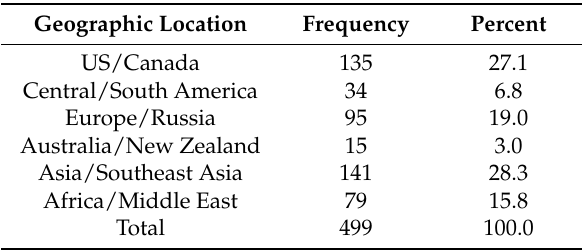
Table 3. Geographic location of survey